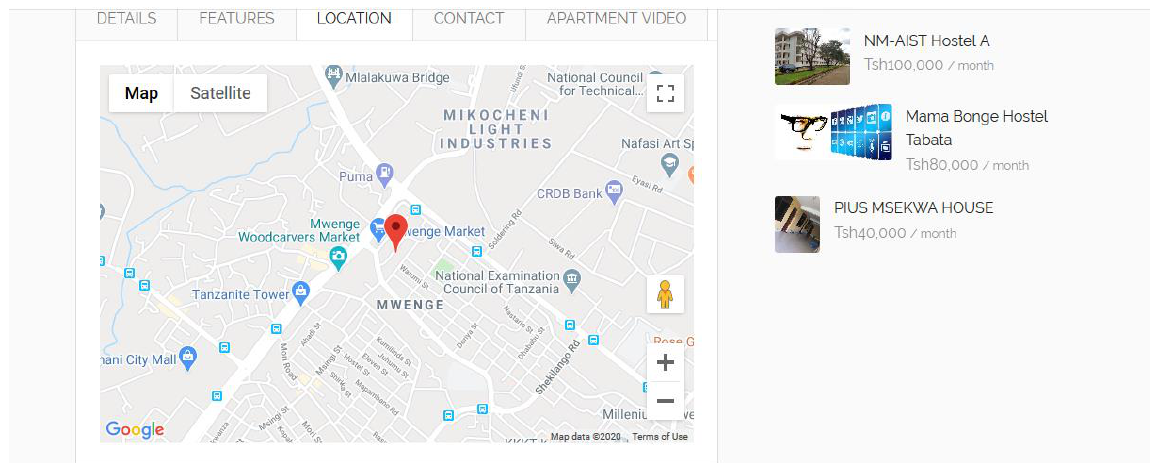
Figure 17. Geographical Location of the Accommodation on the Map